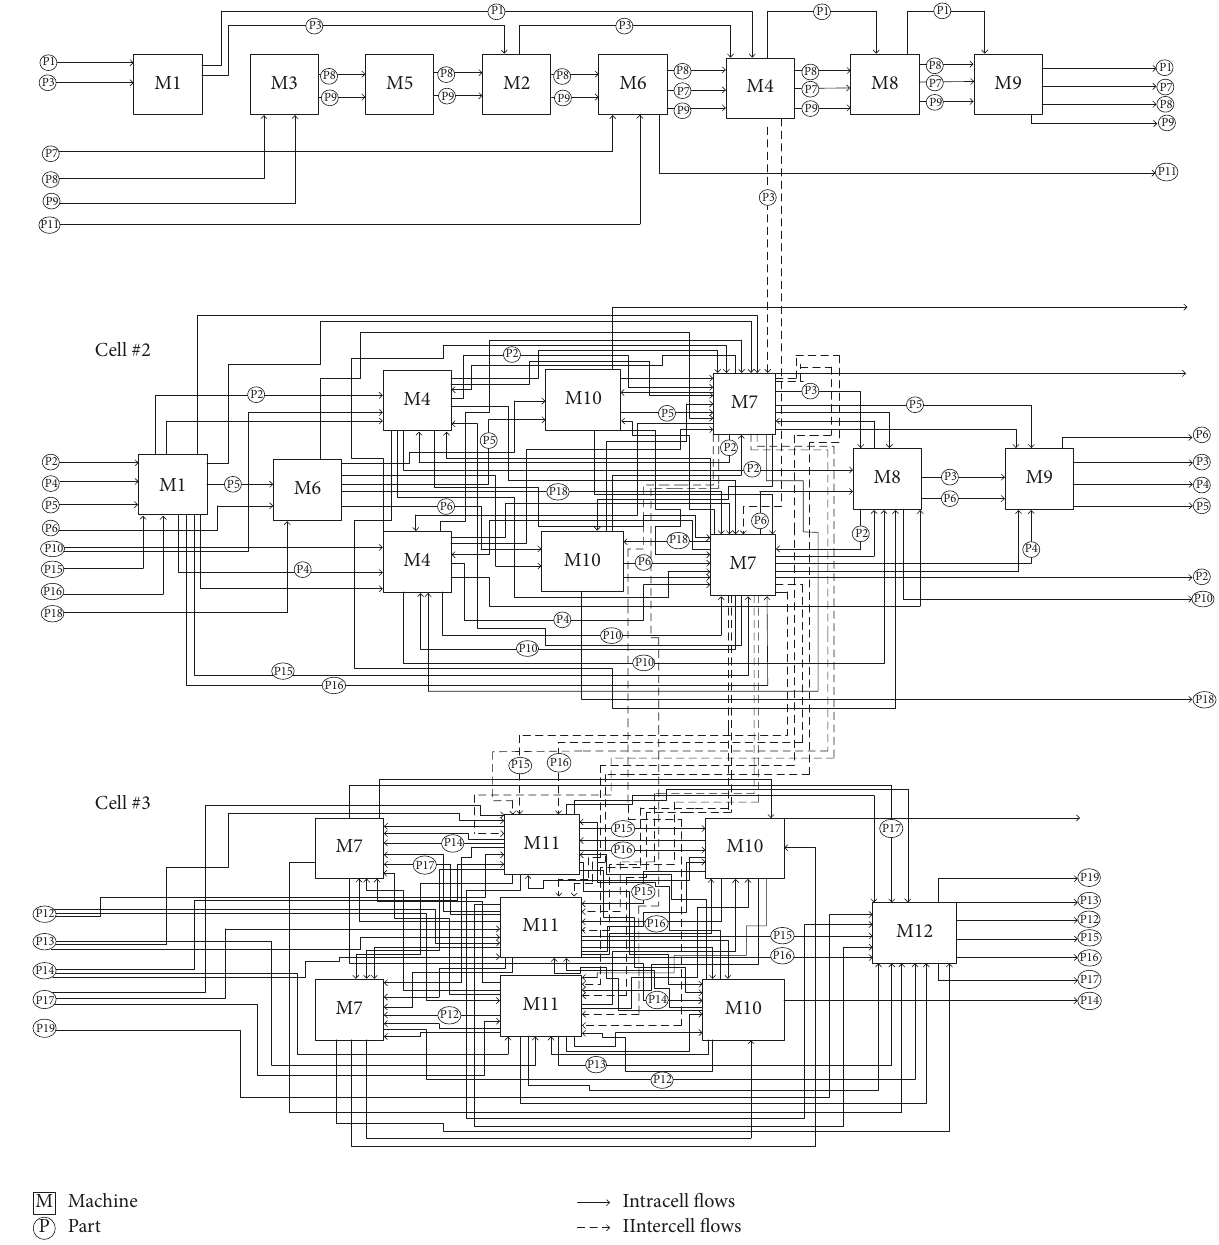
Figure 12: MPC4 and its part flows divided into 3